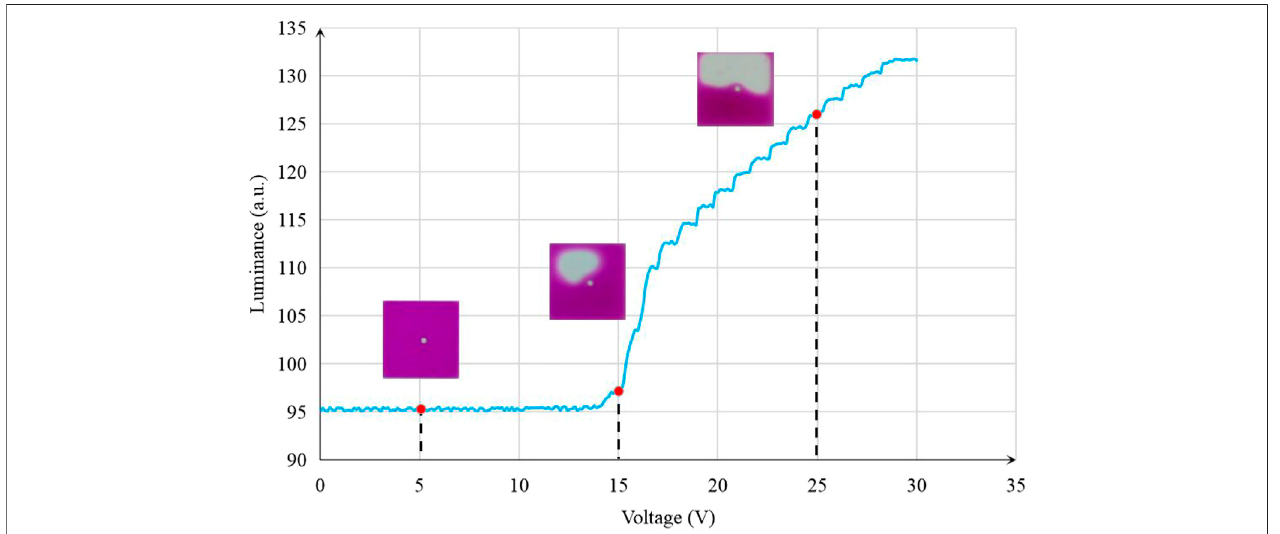
FIGURE 7 | Luminance – voltage curve of an EWD when it was driven by a DC voltage. The EWD began to respond quickly when the voltage was 15 V. The threshold voltage of the oil fi lm rupture was con fi rmed to be 15 V.